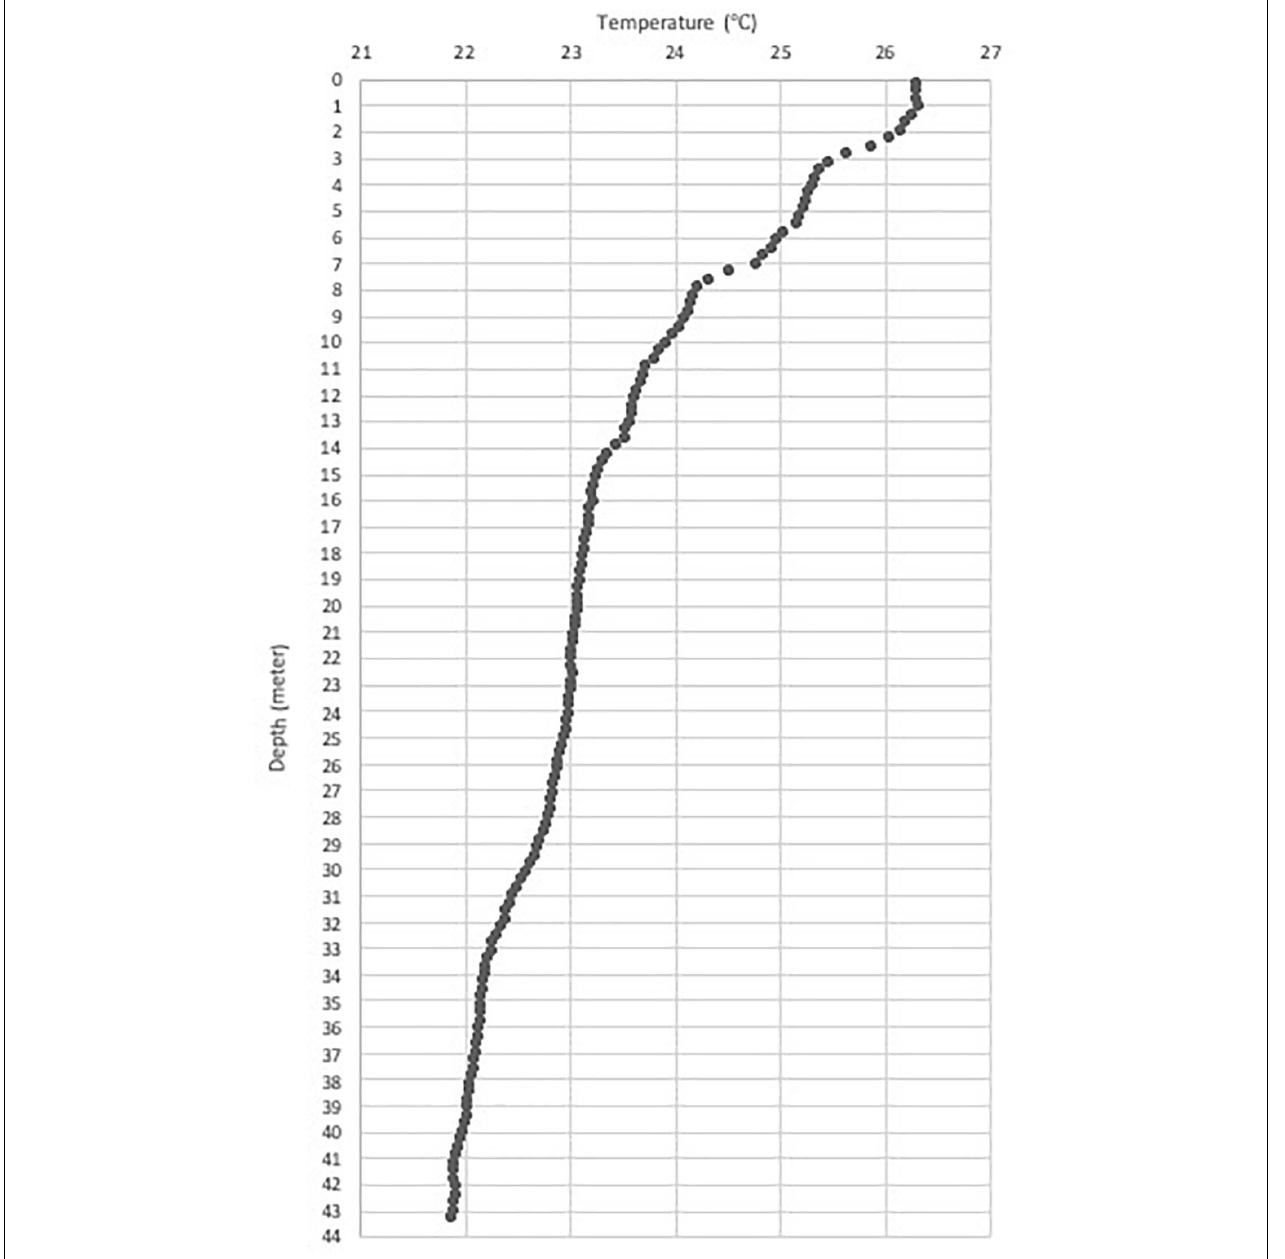
FIGURE 6 | The observed thermocline on 1 November 2015 during sightings of Bryde’s whales and manta